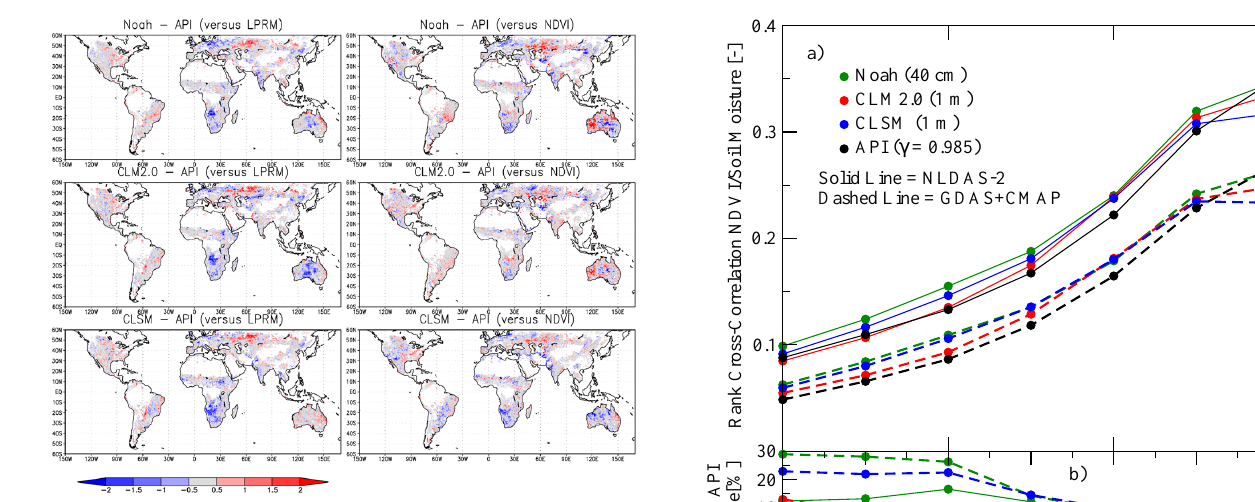
Fig. 6. Quasi-global map of 0.25 ◦ Z -scores for the difference R LPRM ( − 1 ) LSM minus R LPRM ( − 1 ) API (use of LPRM surface soil moisture retrievals as target variable; left column) and R( − 1 ) LSM minus R( − 1 ) API (use of NDVI as target variable; right column) where LSM estimates are obtained from Noah, CLM2.0, and CLSM.